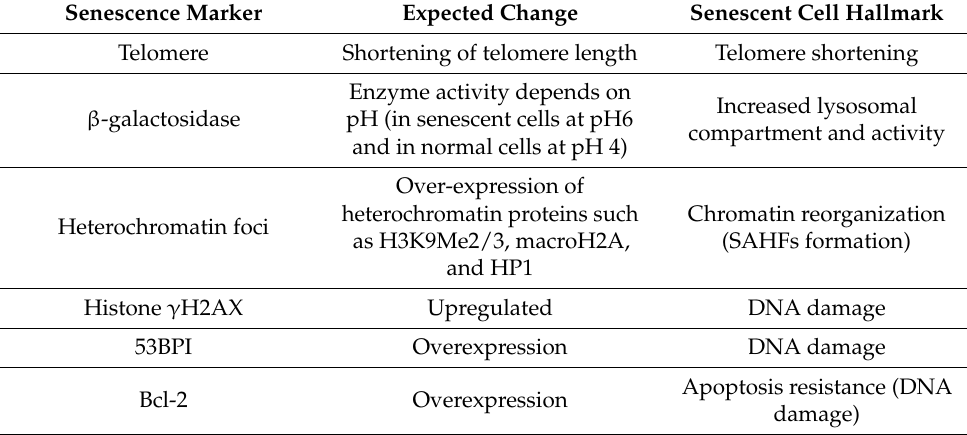
Table 1. Senescence